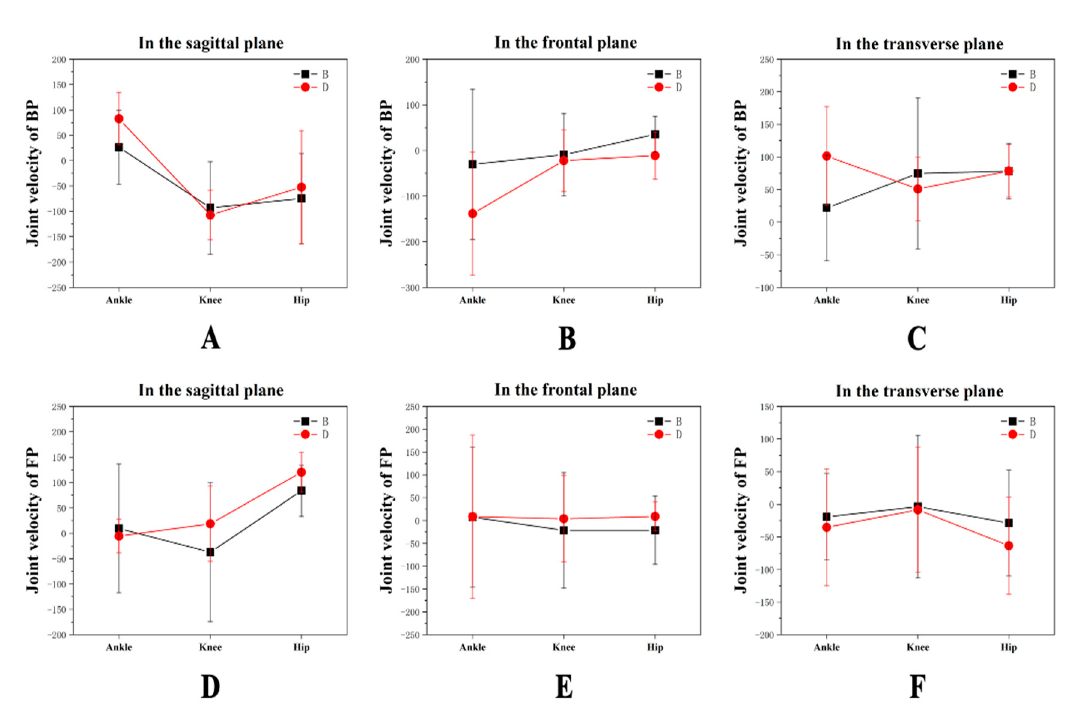
Figure 6. Comparison of the joint velocity values in the BP and FP between MA and FA. ( A – C ) Joint velocity values for the lower limb during the BP in three planes. ( D – F ) Joint velocity values for the lower limb during the FP in three planes.